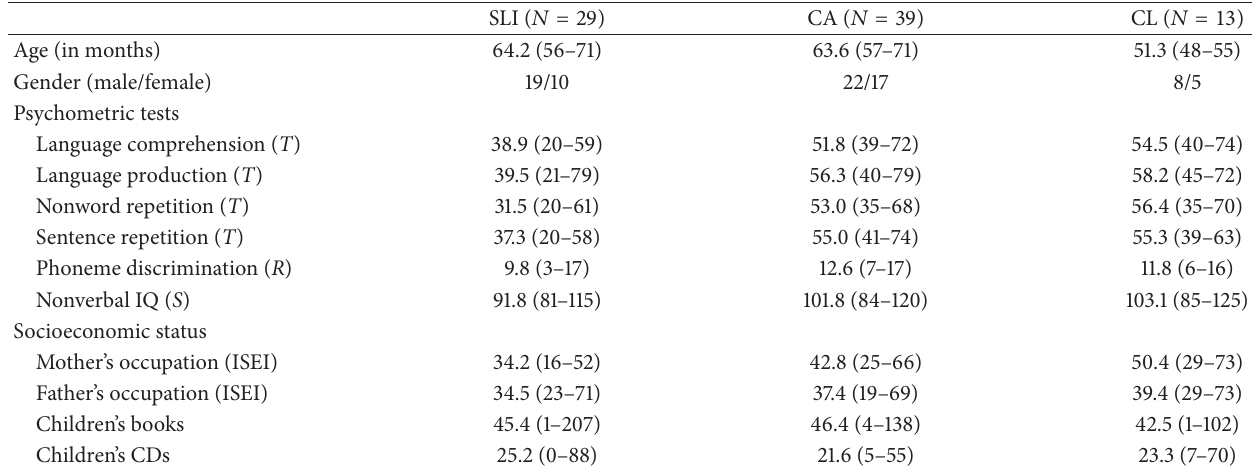
Table 1: Summary of characteristics of the three groups of participants (SLI: Children with Specific Language Impairment; CA: children of comparable age; CL: children with comparable linguistic abilities) encompassing age and gender distribution, performance in psychometric tests (language screening and general cognitive skills), and variables reflecting the socioeconomic background. ( T ): T -scores, ( S ): standard scores, ( R ): raw